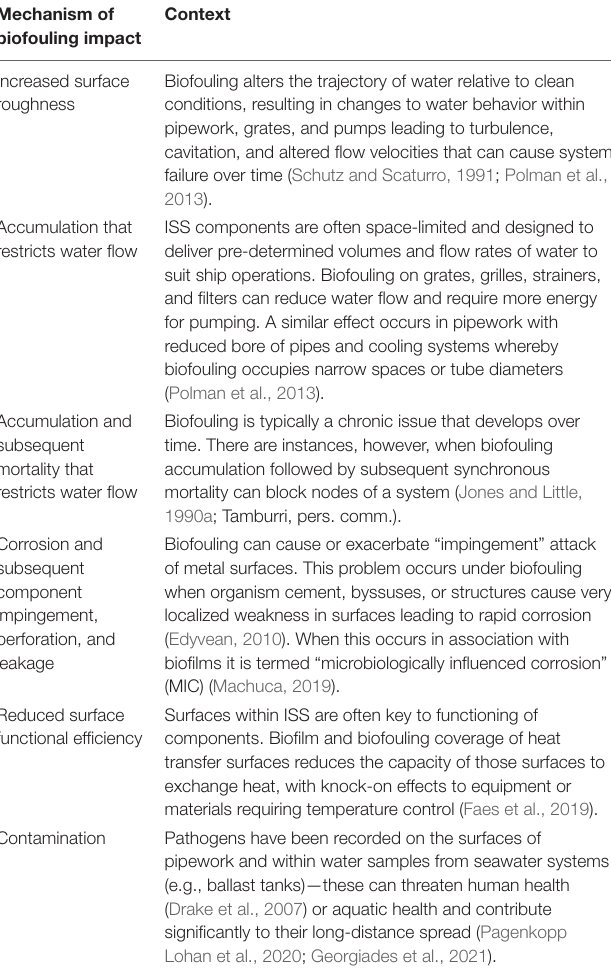
TABLE 1 | Mechanisms of biofouling impact within ships’